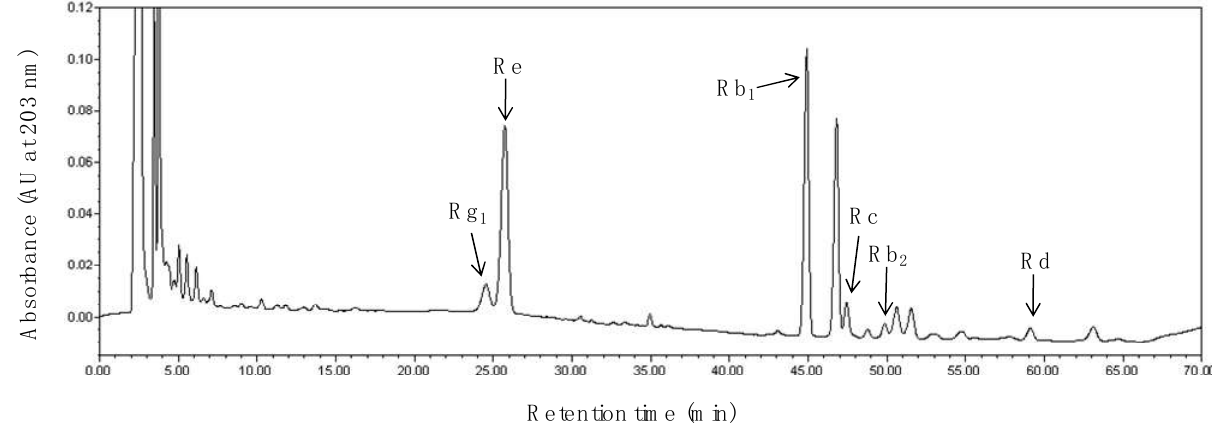
Figure 2. Representative retention peaks of a high performance liquid chromatography (HPLC) separation of ginsenoside Rg ginseng roots.